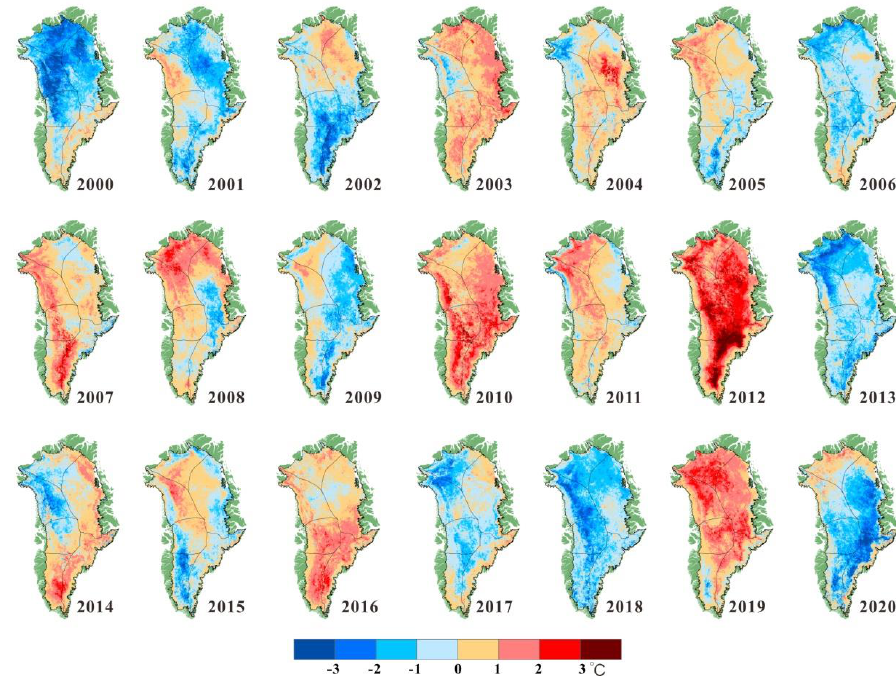
Figure 4. Summer LST anomaly of the GrIS from 2000 to 2020.